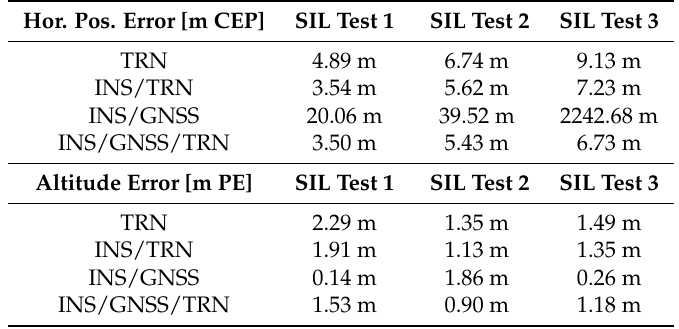
Figure 10. Results of SIL Test 3 when GNSS is unavailable in the whole area. ( a ) Horizontal position error. ( b ) Horizontal position error without INS/GNSS-aided navigation error. ( c ) Altitude error without TRN and INS/TRN-aided navigation error. ( d ) Altitude error. Table 2. Simulation results of the SIL tests in a GNSS-denied